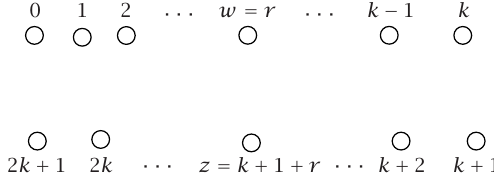
2 k + 1 according to Lemma A.1.